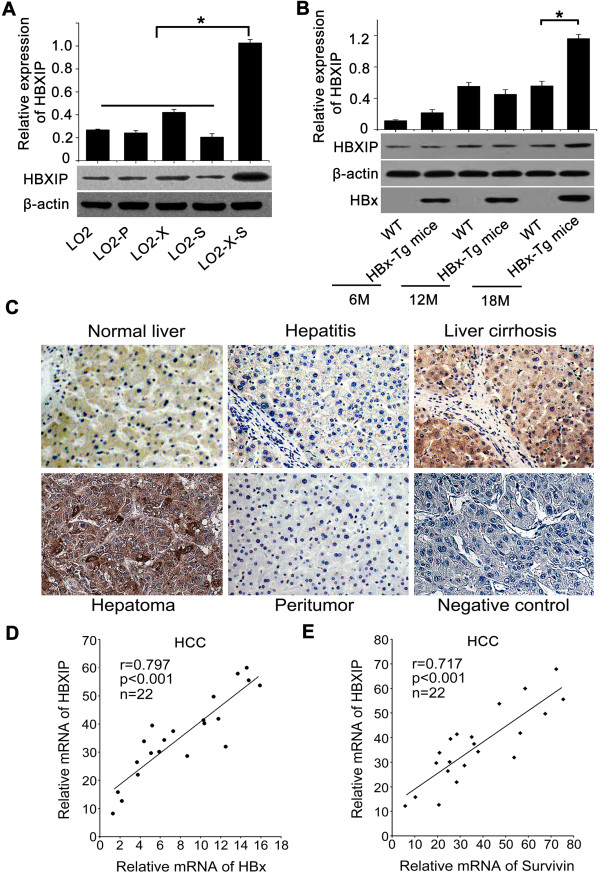
HBx up-regulates HBXIP in HBx-Tg mice and HCC tissues with partner survivin. (A) The expression of HBXIP was detected by western blotting in LO2 and engineered cell lines (*P < 0.05, Student’s t test). (B) The expression of HBXIP in the liver tissues of p21-HBx-Tg mice aged 6, 12 and 18 mouths versus WT littermate mice were determined by western blotting, respectively (*P < 0.05, Student’s t test). (C) Expression of HBXIP was examined by IHC staining in the clinical tissues of normal liver, hepatitis, liver cirrhosis, HCC and peritumor tissues. (D, E) Correlation between relative expression of HBXIP and that of HBx (or survivin) was examined by qRT-PCR in 22 cases of HCC tissues (***P <0.001, r = 0.797 or r = 0.717; Pearson’s correlation coefficient). Data presented are from three independent experiments.